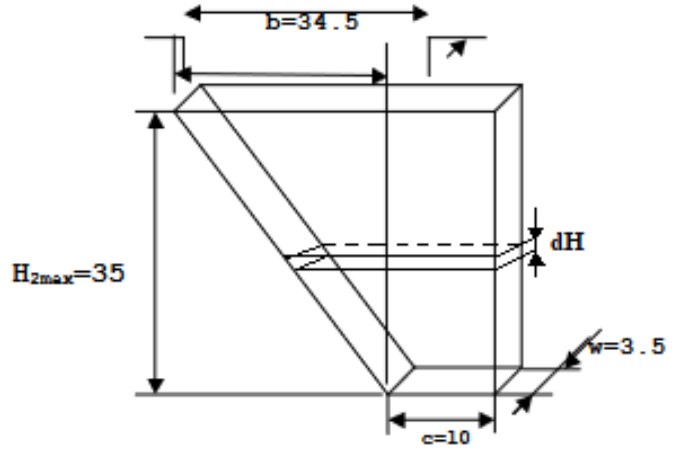
Figure 3. Geometry of the tank in which the water level was maintained—dimensions given in cm (source: